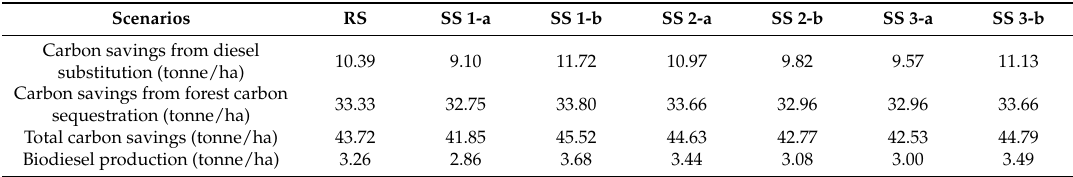
Table A5. Annual biodiesel production and total carbon savings of RS and